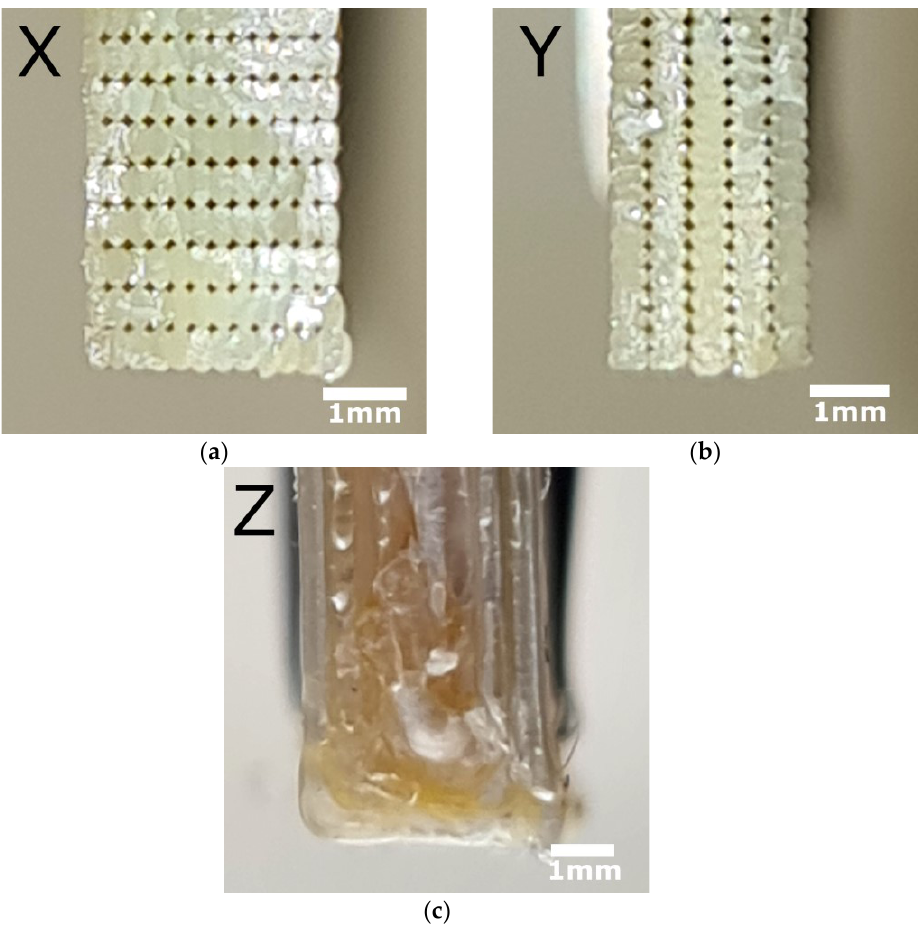
Figure 3. Transverse cross-sections of Ultem samples after cooling at RT printed in X ( a ), Y ( b ), and Z ( c ) directions and studied by optical microscopy.